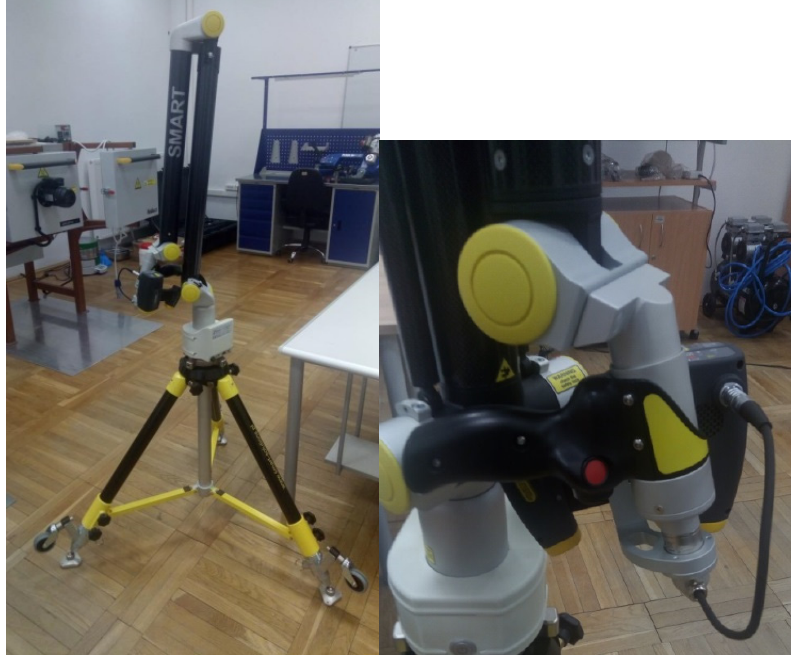
Figure 3. View of the Nikon Model Maker MMDx scanner mounted on an arm along with the tripod base and laser head.